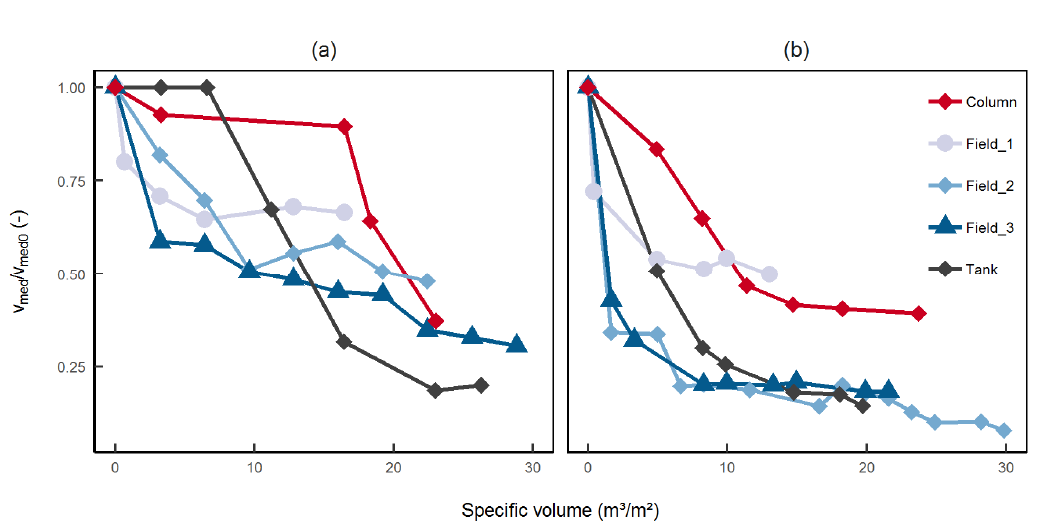
Figure 4. Relative reduction of median flow velocity in point 1.2 in ( a ) scenario 1 (wet/dry ratio: 24 h/72 h) and ( b ) scenario 2 (wet/dry ratio: 168 h/168 h) for the column and tank under climate 2 (mild) as well as the field under climate 1 (cold), 2 (mild) and 3 (warm).